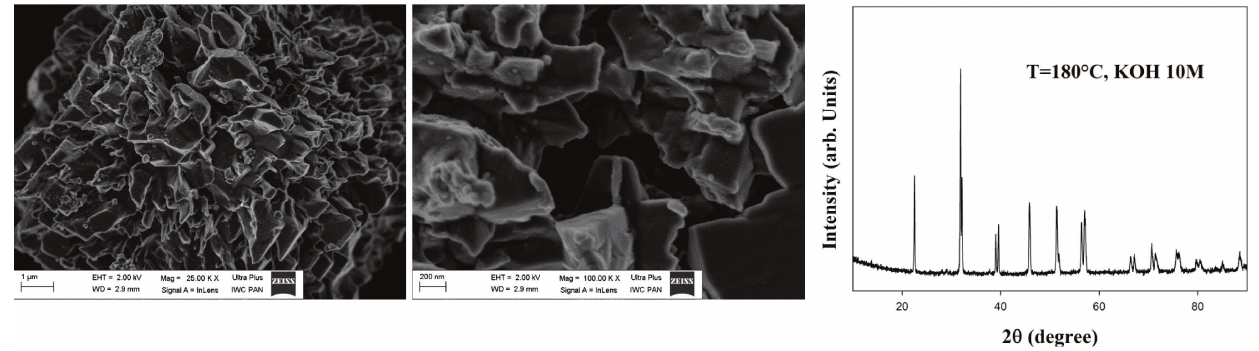
Figure 4. Scanning electron microscopy (SEM) images and X-ray diffractometry (XRD) ) phase synthesized according to the pattern of pure bismuth ferrite (BiFeO 3 microwave-assisted hydrothermal procedure optimized in [74], i.e. , at 180 °C for 30 min with a KOH concentration of 10 mol/L.